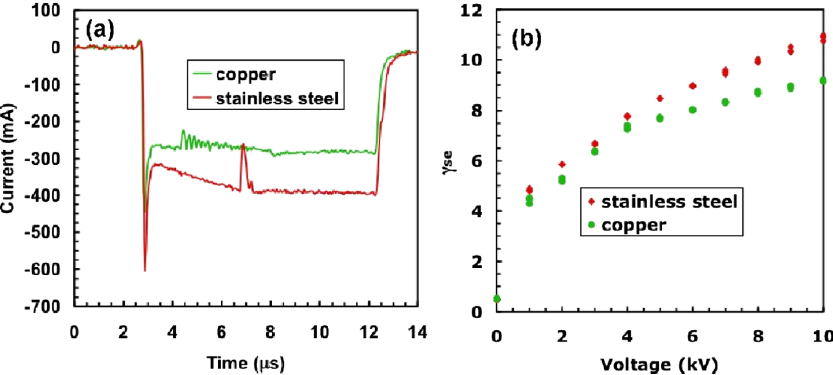
FIG. 18. (Color) (a) Secondary electron current collected on the parallel plate biased at (cid:1) 10 kV when the beam is intercepted with a stainless steel plate (red); and a copper plate (green). (b) Secondary emission coefficient versus bias potential over a 200 ns gate at 3 : 2 (cid:1) s .